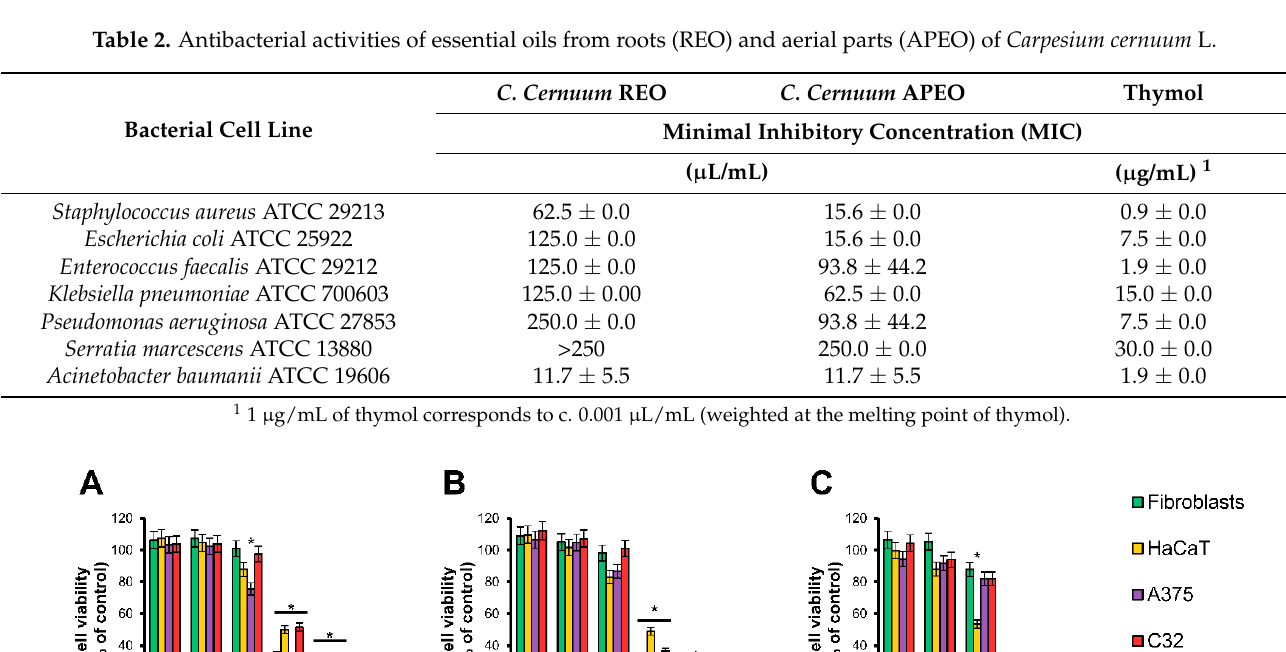
Table 2. Antibacterial activities of essential oils from roots (REO) and aerial parts (APEO) of Carpesium cernuum L.